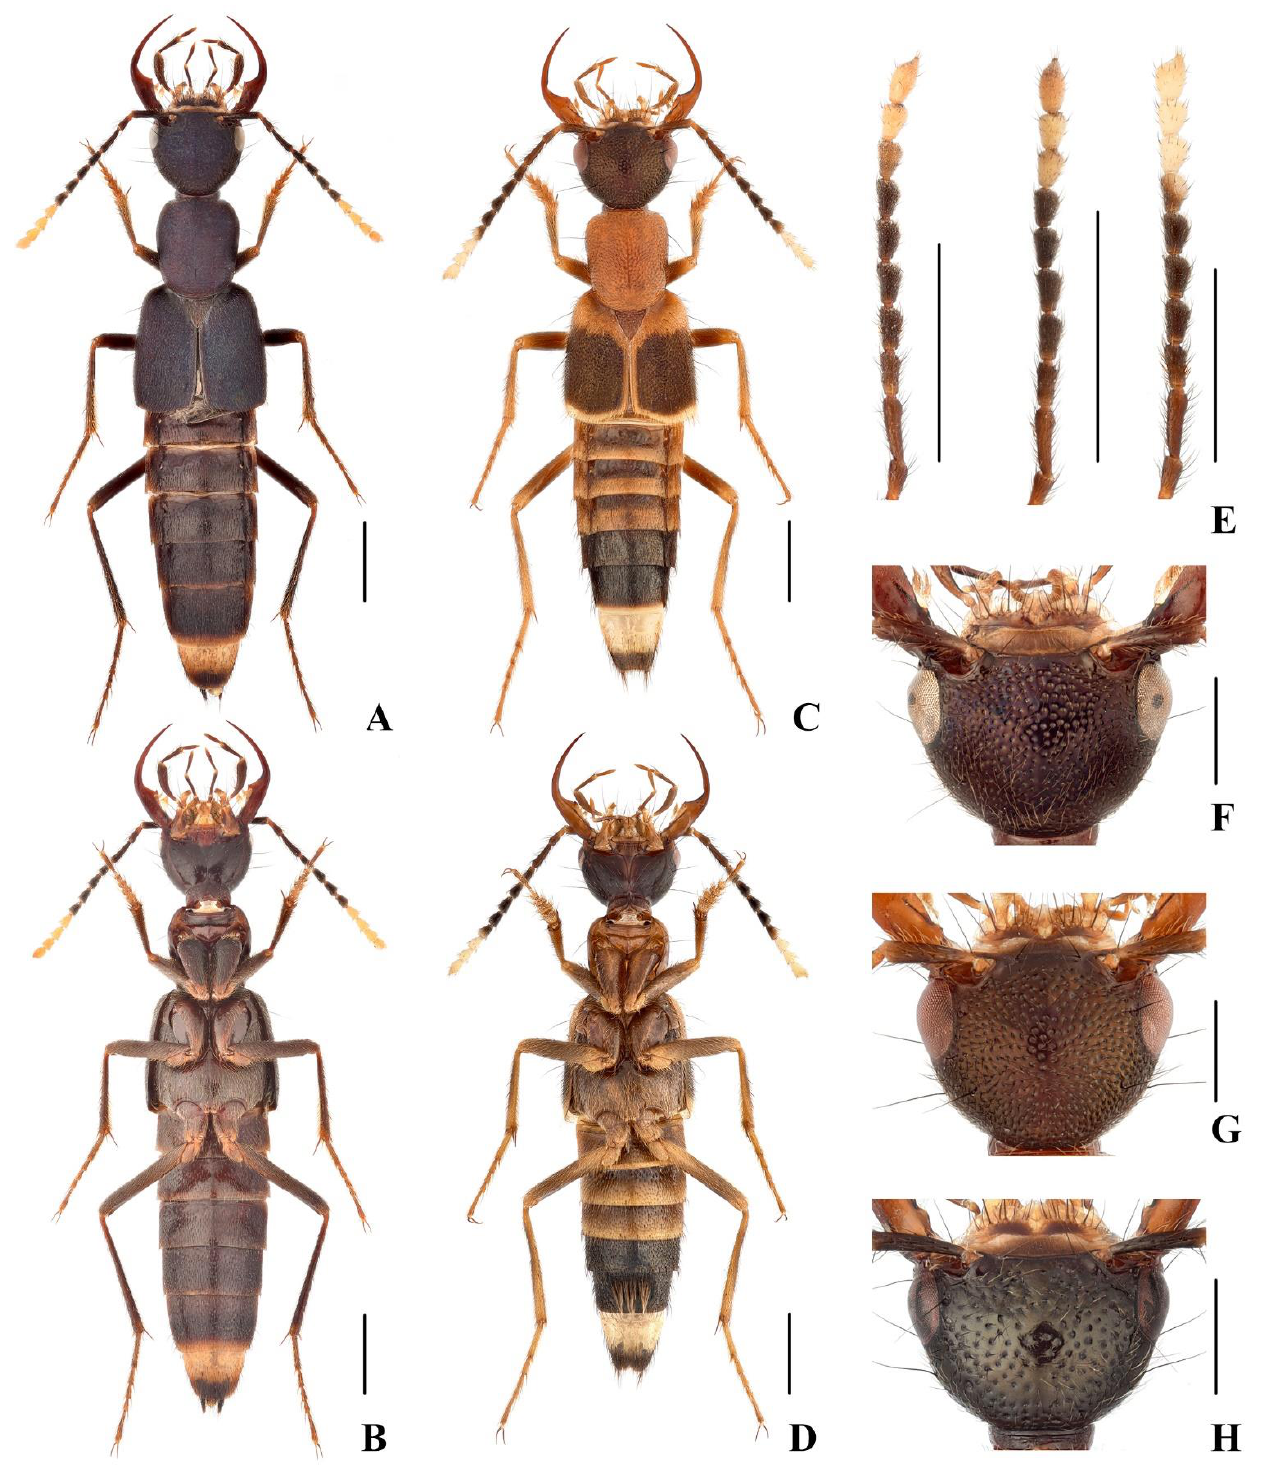
Figure 2. ( A – D ) Adult of Hesperoschema . ( A , B ) Adult habitus of H. opacum ; ( C , D ) adult habitus of H. sinicum ; ( E ) antennae of H. sinicum ; ( F – H ) . Head of Hesperoschema . ( F ) H. xuwangi ; ( G ) H. sinicum ; ( H ) H. bii . Scale bars: 2 mm ( A – D ), 1 mm ( E – H ). Pronotum 1.10 times as long as wide, widest at about level of large lateral seta, nar- rowed toward base in shallow concave arc; surface as moderately densely and coarsely punctate as on head, with distinct impunctate midline, surface of pronotum between